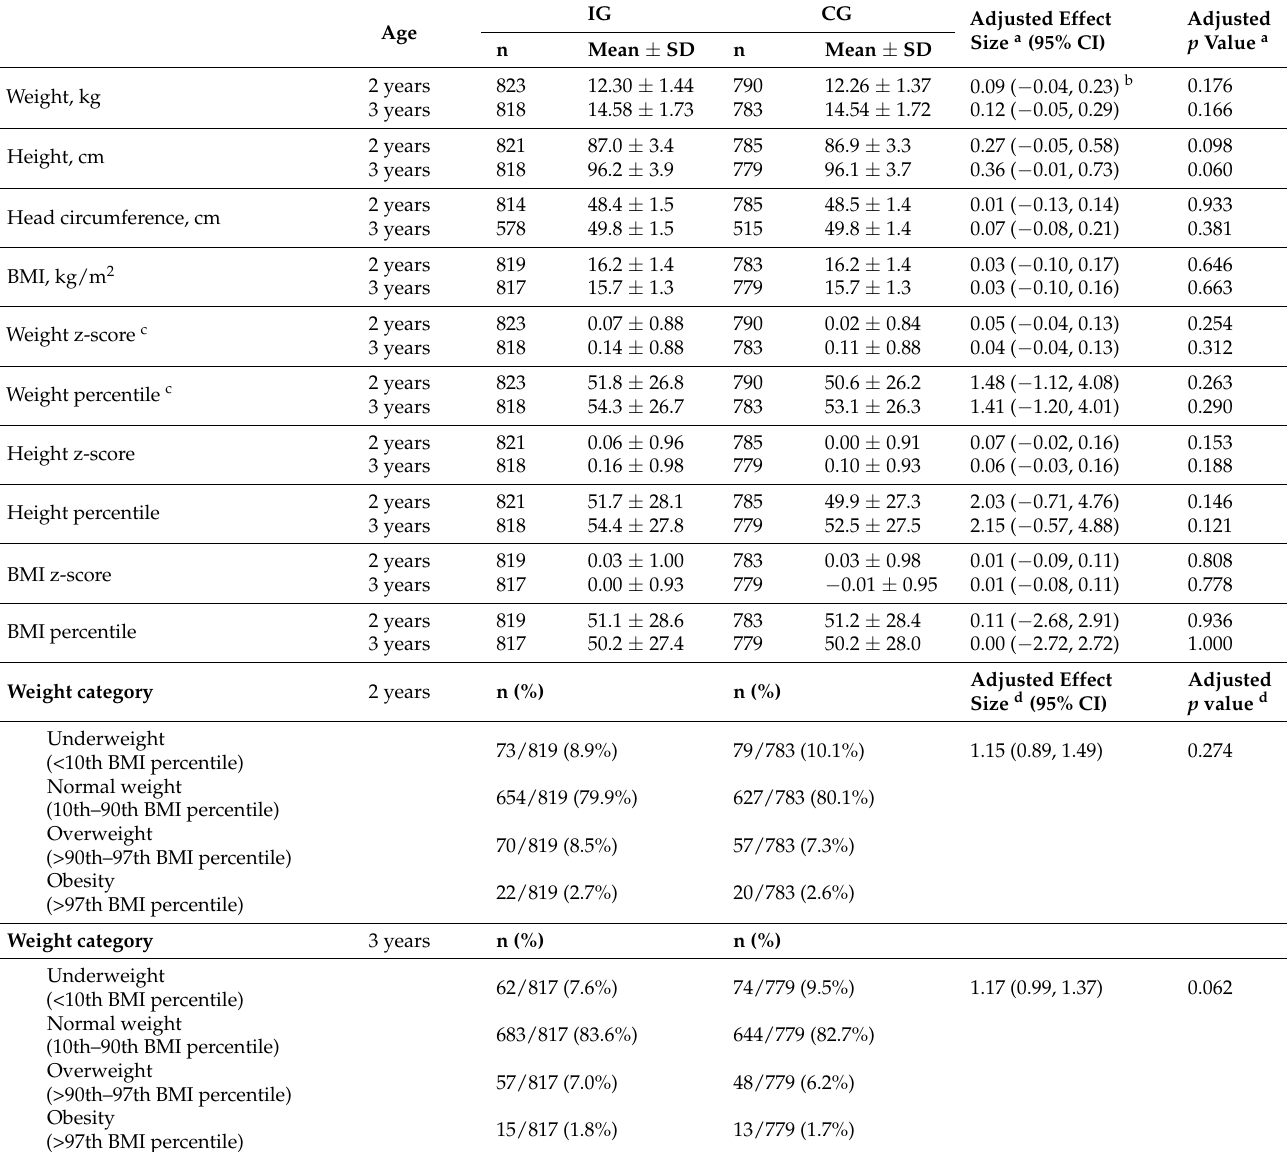
Table 2. Child anthropometrics at 2 and 3 years of